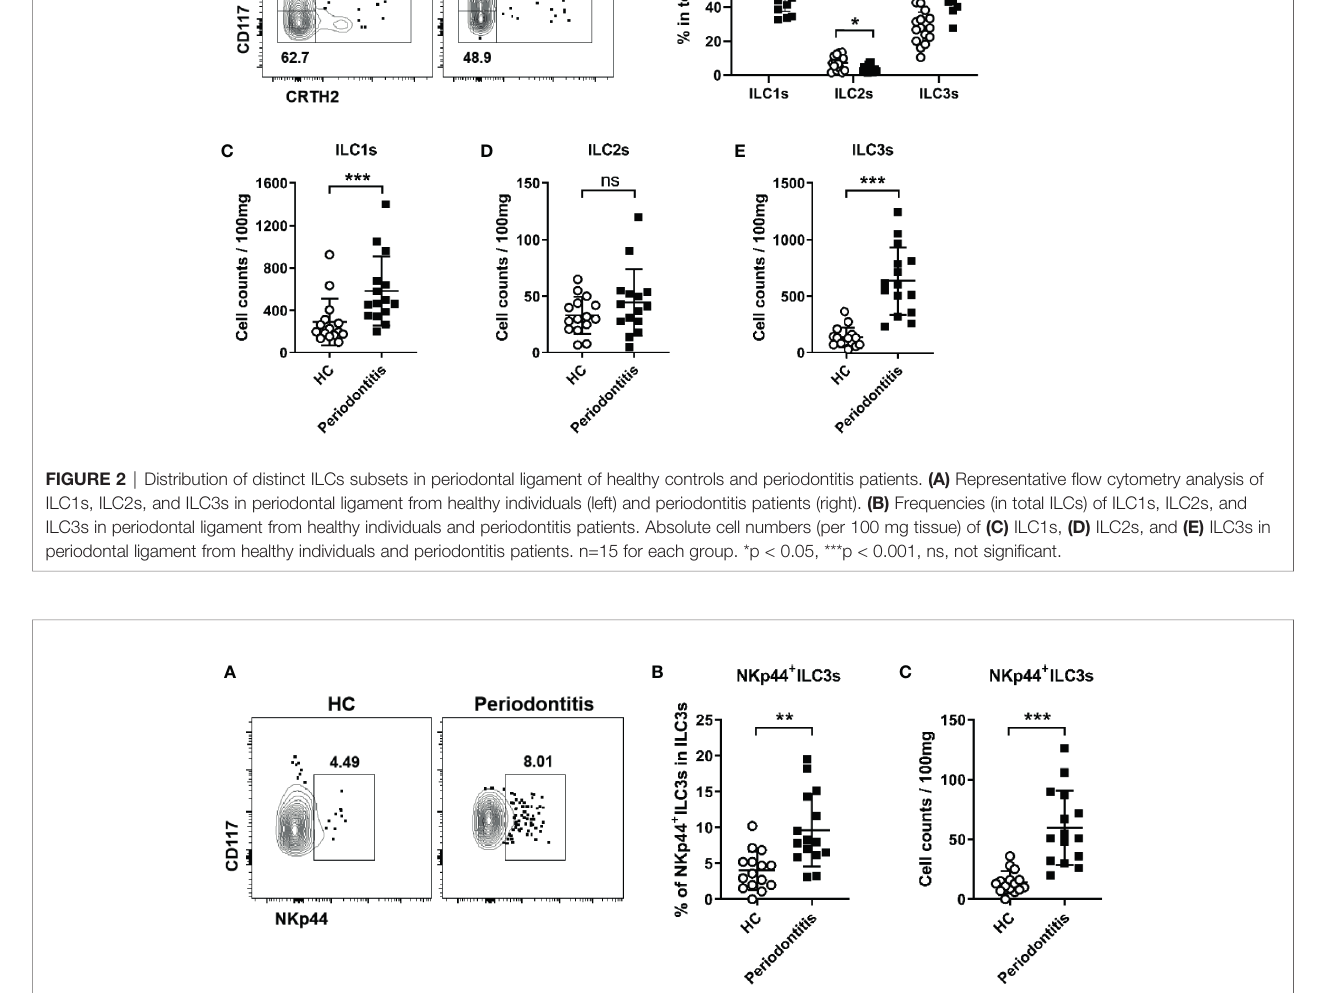
FIGURE 3 | Increased NKp44 + ILC3s in periodontal ligament of periodontitis patients. (A) Representative fl ow cytometry analysis of NKp44 + ILC3s in periodontal ligament from healthy individuals (left) and periodontitis patients (right). (B) Frequency (in total ILC3s) and (C) absolute cell numbers (per 100 mg tissue) of NKp44 + ILC3s in periodontal ligament from healthy individuals and periodontitis patients. n = 15 for each group. **p < 0.01, ***p <